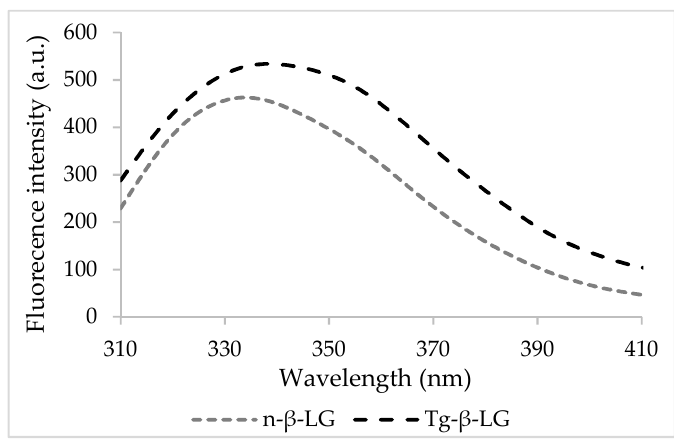
Figure 1. The fluorescence intensity spectra of the native and cross-linked β-lactoglobulin.